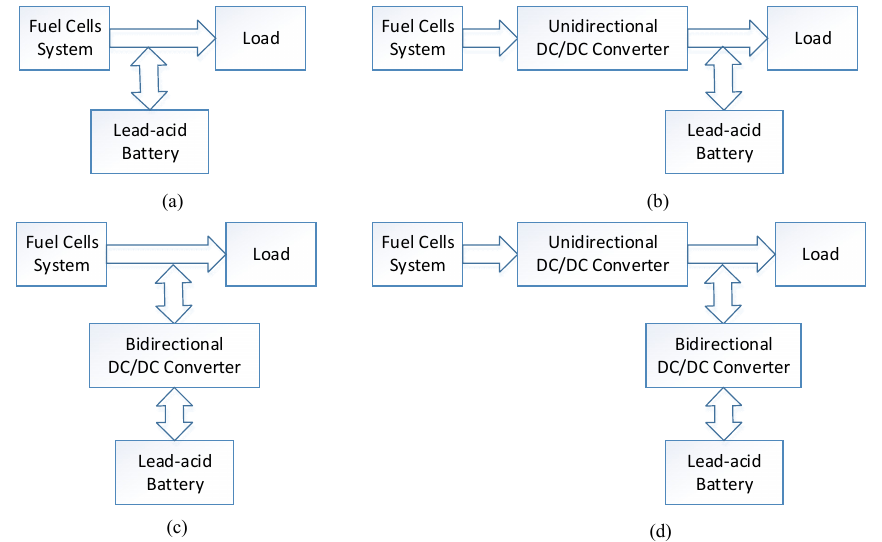
Figure 1. Topology of the fuel cell/battery hybrid power system. ( a ) Simple topology of the hybrid power system; ( b ) topology of the hybrid power system with an unidirectional DC/DC converter; ( c ) topology of hybrid power system with a bidirectional DC/DC converter; and ( d ) the topology of the hybrid power system with unidirectional and bidirectional DC/DC converters.